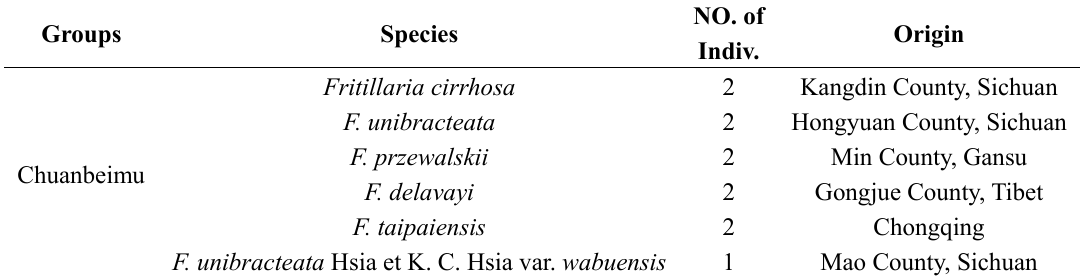
Table 1. Plant species, origins and groups for medicinal